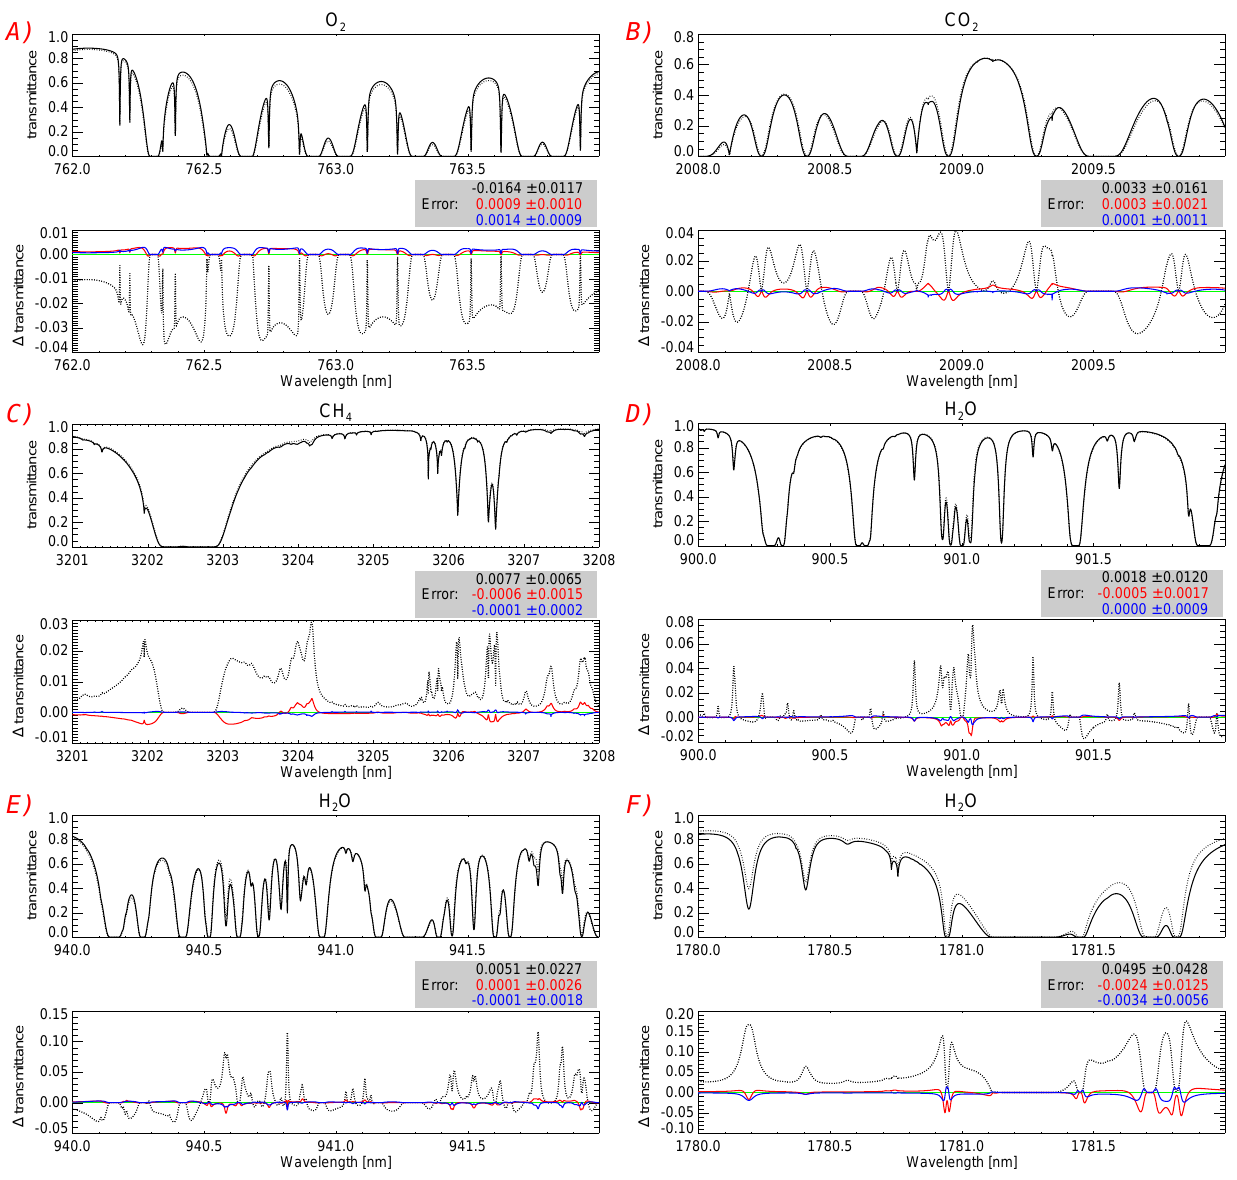
Fig. 8. Transmittance for tropical atmosphere (airmass = 3, upper panels) and accuracy of approximated transmittance (lower panels) for various gases ( A : O 2 , B : CO 2 , C : CH 4 , D–F : water vapour). Black dotted lines show errors in the case average temperature profile is used, red and blue lines indicate errors when using 4 principal components, (red: first derivative only, blue: including second derivative). The associated accuracy and precision of the approximated transmittance are given in the grey shaded boxes, calculated from the spectral ranges